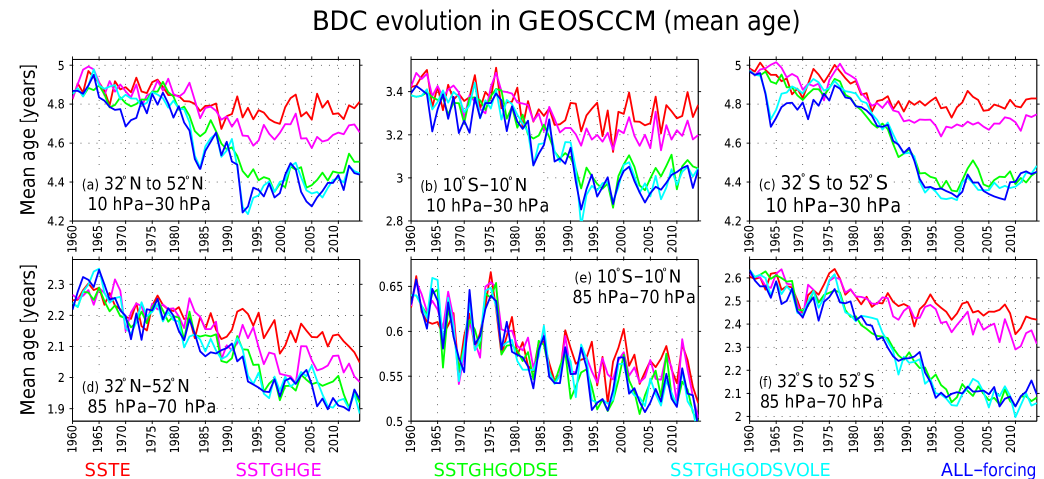
Figure 6. Time series of annual averaged mean age in the NH (left), tropics (middle), and SH (right). Each line is for one ensemble mean. Blue is all forcing, red is SST only, and intermediate colors span the other three experiments performed. Changes in the mid-stratosphere (deep branch) are shown in (a–c) , and changes in the lower stratosphere (shallow branch) are shown in (d–f)